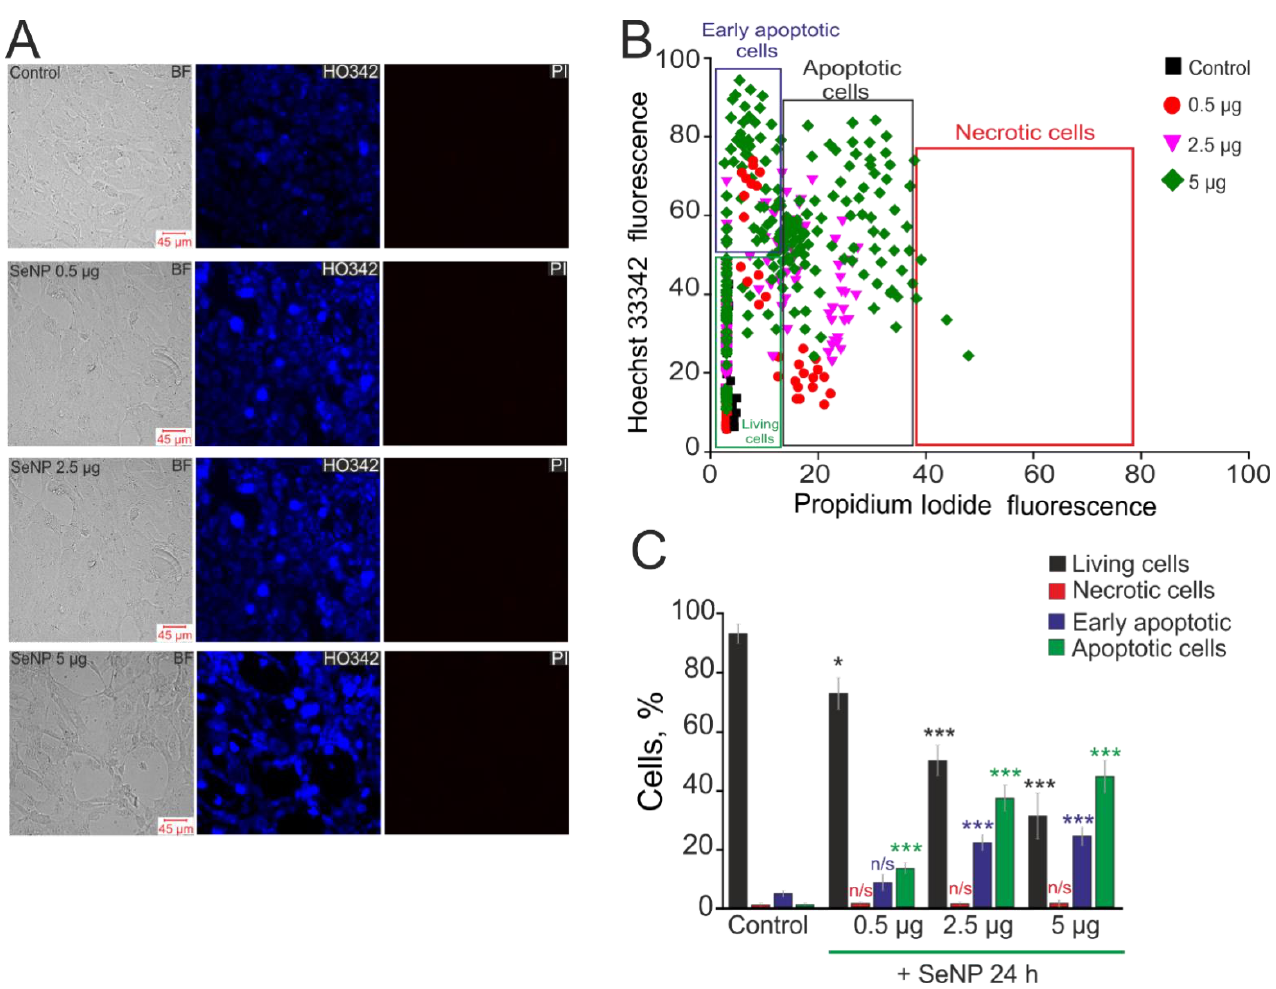
Figure 6. The effect of different concentrations of SeNP on induction of apoptosis and necrosis in the A-172 cells. ( A ) Double staining of cells with Hoechst 33,342 (HO342) and Propidium iodide (PI) after incubation with SeNP. ( B ) Cytogram of the viability of A-172 cells. X -axis—the intensity of PI fluorescence; Y -axis—the intensity of Hoechst 33,342 fluorescence. Cells were stained with the probes after 24 h of SeNP application. ( C ) The percentage of living cells (black column) and cells in which the processes of early apoptosis (violet column), apoptosis (green column), and necrosis (red column) were detected after incubation with SeNP. The differences between the control and experimental groups are marked with asterisks—* p < 0.05 and *** p < 0.001. n/s—differences insignificant.